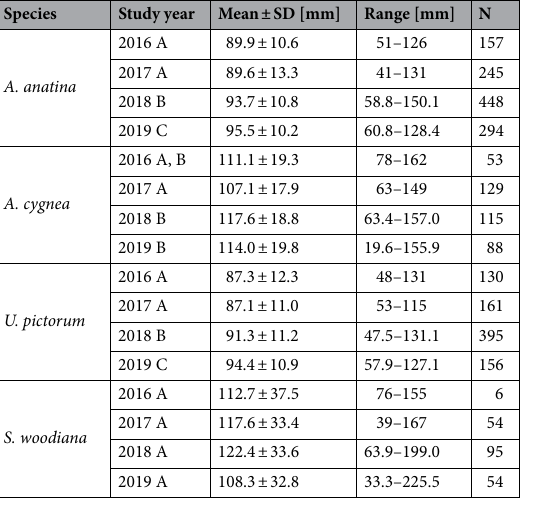
Table 1. Summary statistics of shell length in co-occurring mussel populations in 2016—2019. Letters A, B, C denote significant differences in the Kruskal–Wallis test with Dunn’s pairwise comparison, Bonferroni corrected significance level P = 0.0083.